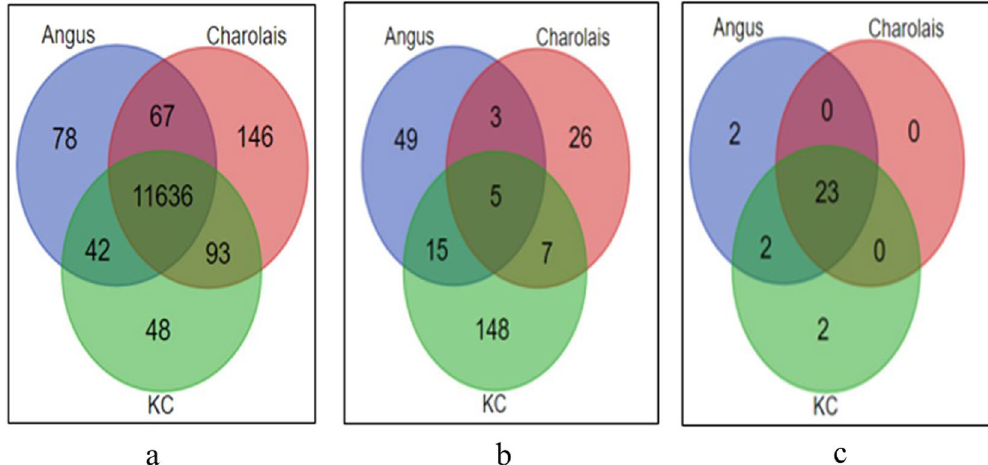
Figure 1. Venn diagrams showing: ( a ) overlap of expressed genes ( > 1CPM in ≥ 6 samples) in the three studied breed populations; ( b ) overlap of differentially expressed genes (DE genes) in the three studied breed populations; ( c ) overlap of biological functions enriched by DE genes identified in the three studied breed